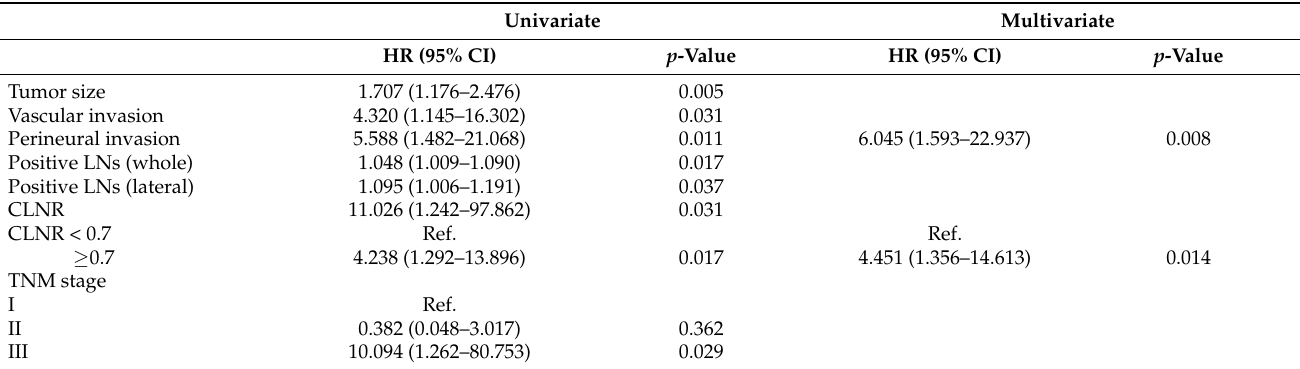
Table 4. Univariate and multivariate analyses of the risk factors for